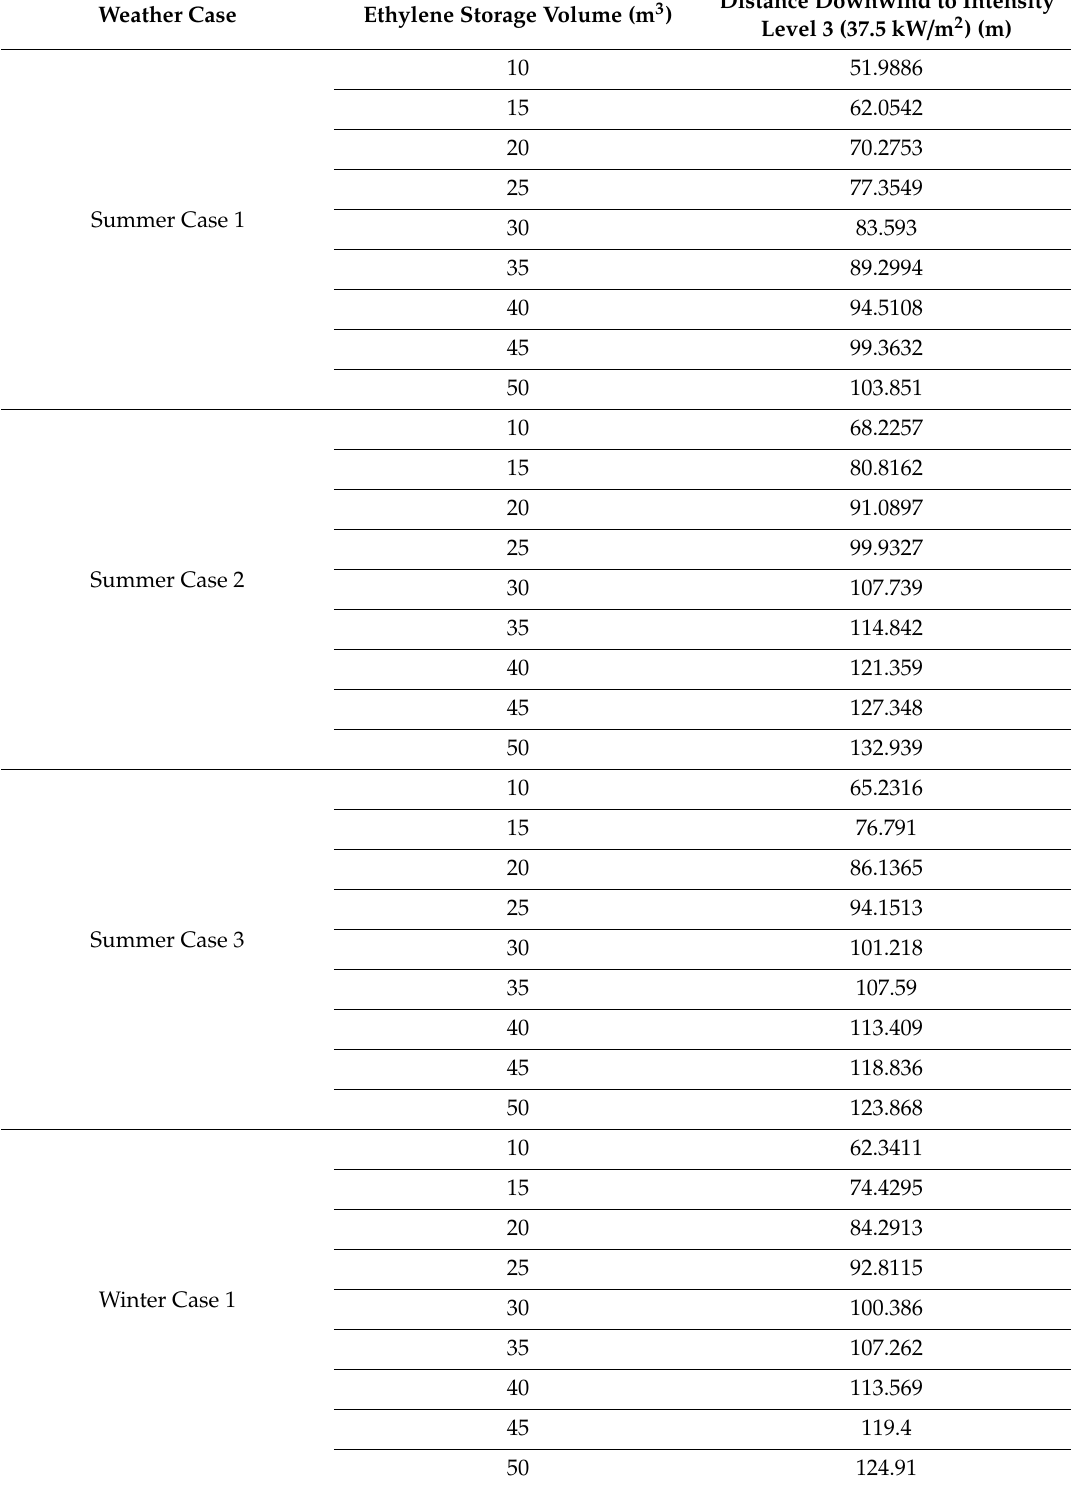
Table 7. Simulation results in summer (40 ◦ C) and winter (0 ◦ C)